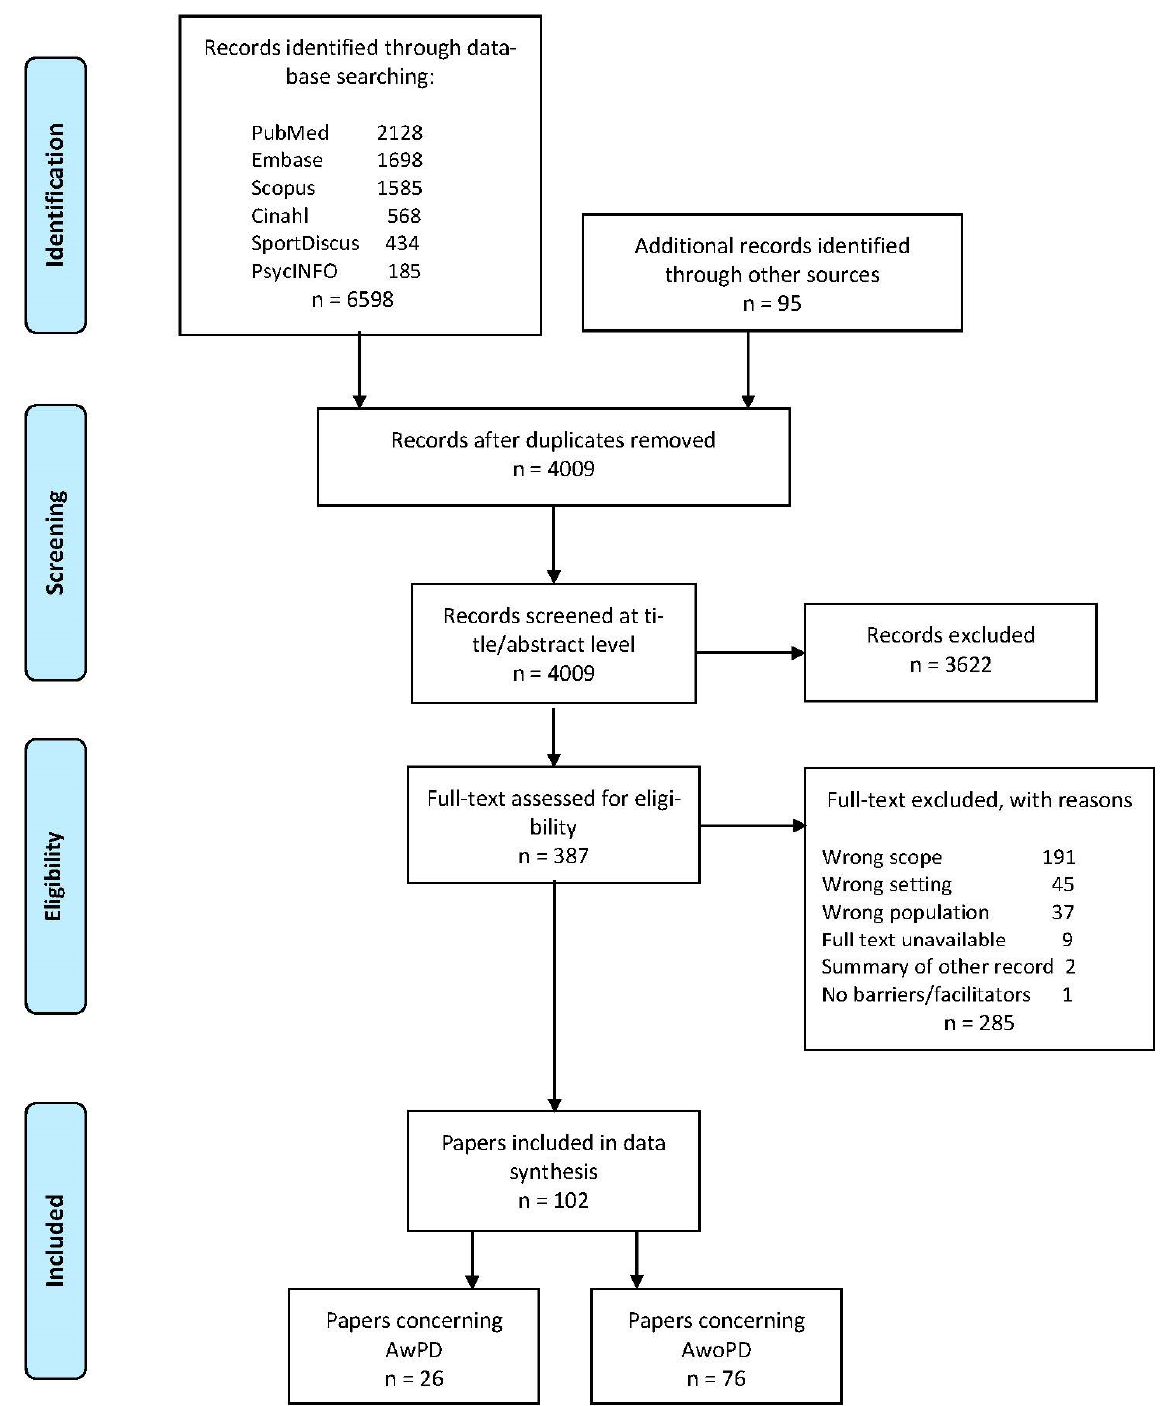
Figure 1. Study selection process illustrated in a PRISMA flowchart. AwPD = adults with physical disabilities; AwoPD = adults without physical disabilities.